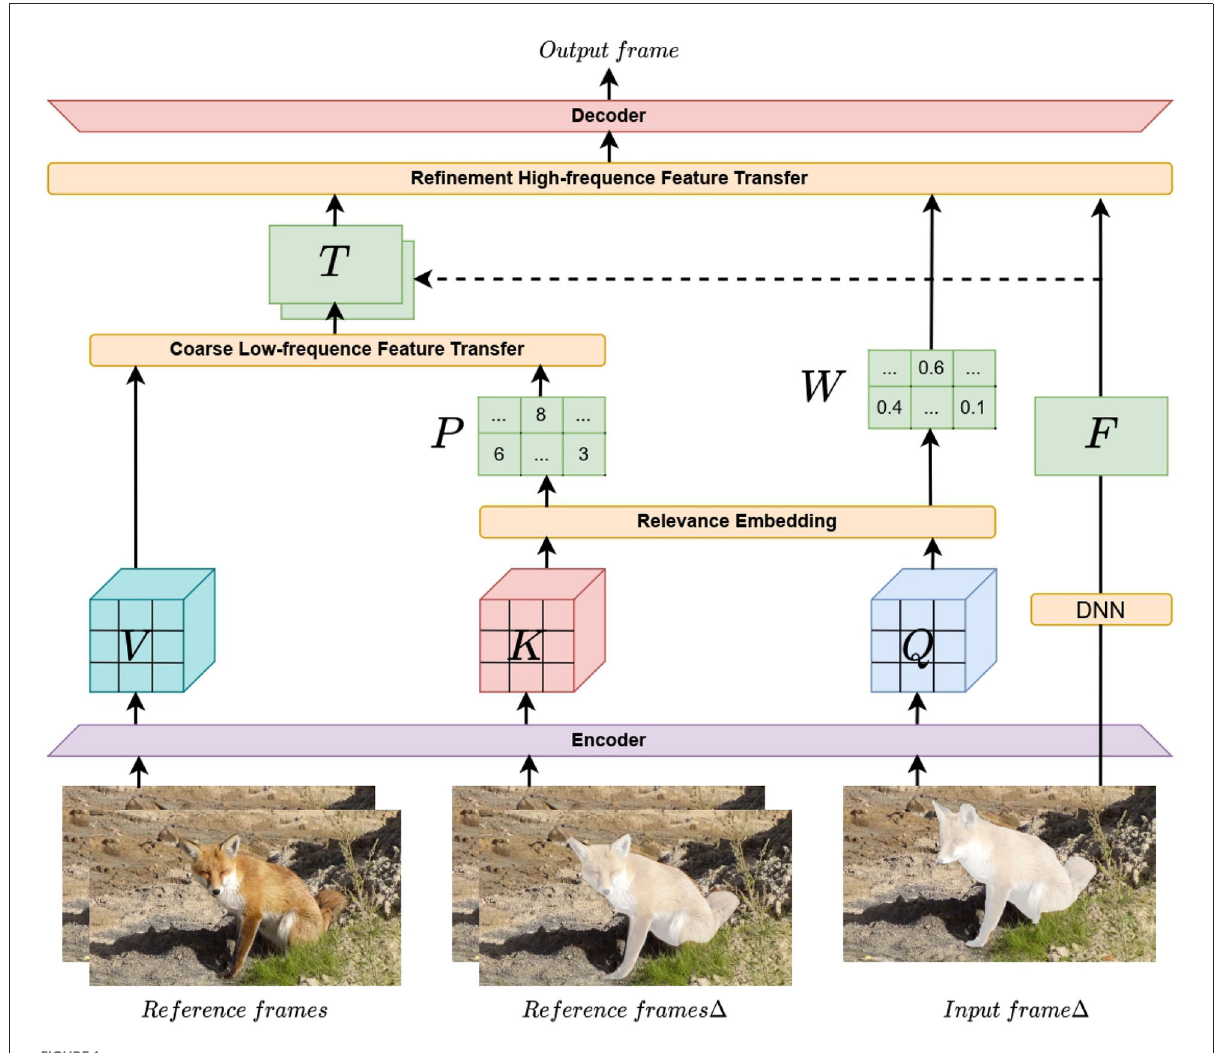
FIGURE1 Overview of spatial-temporal texture transformer network (STTTN)